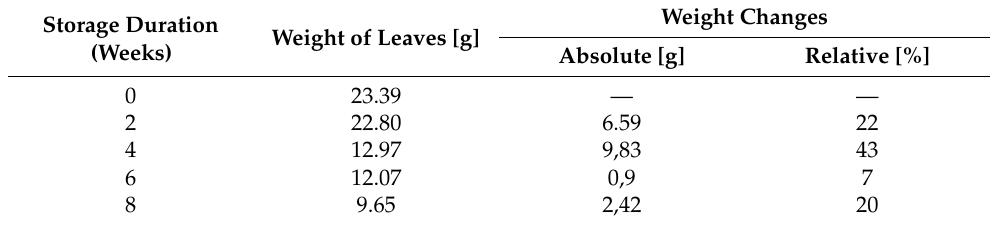
Table 4. Changes in the weight of the leaves.